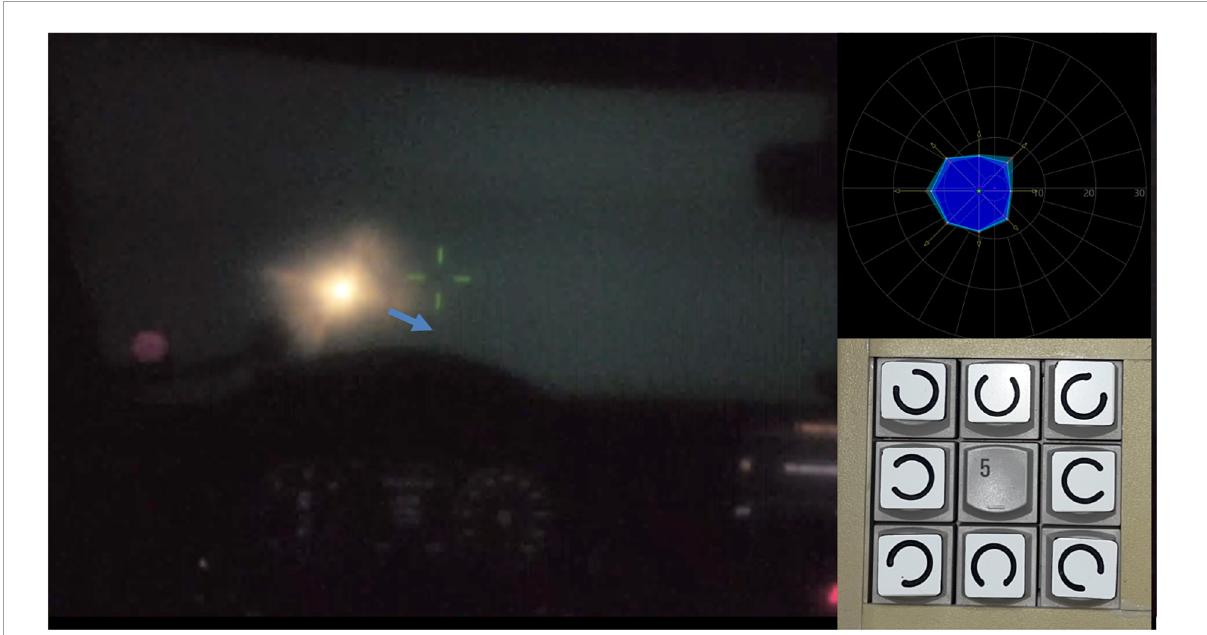
FIGURE2 Illustration of the basic principle of “halometry”; patient’s view with a simulated cataract: a Landolt C, originating from the center of the glare source is crossing the border of the halo area (the origin of the blue arrow indicates the gap position of the optotype and the arrowhead shows the movement direction of the optotype). Right upper insert : examination result for the eight cardinal vectors demarcating the extent (eccentricity) of the halo, shaded in deep blue; the light blue area indicates the intra-subjects scatter, measured by repeated presentation of optotypes along each vector. Right lower insert : modified keypad (Michael Bach, University Eye Hospital, Freiburg, Germany) for the manual input of the (total eight possible) Landolt C’s gap positions.